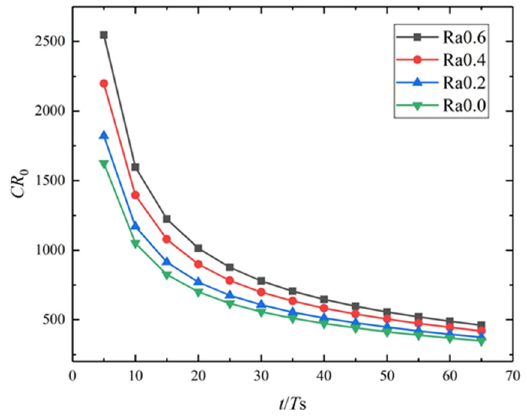
Figure 5. Dimensionless corrosion rate versus dimensionless time for different surface roughnesses Ra.